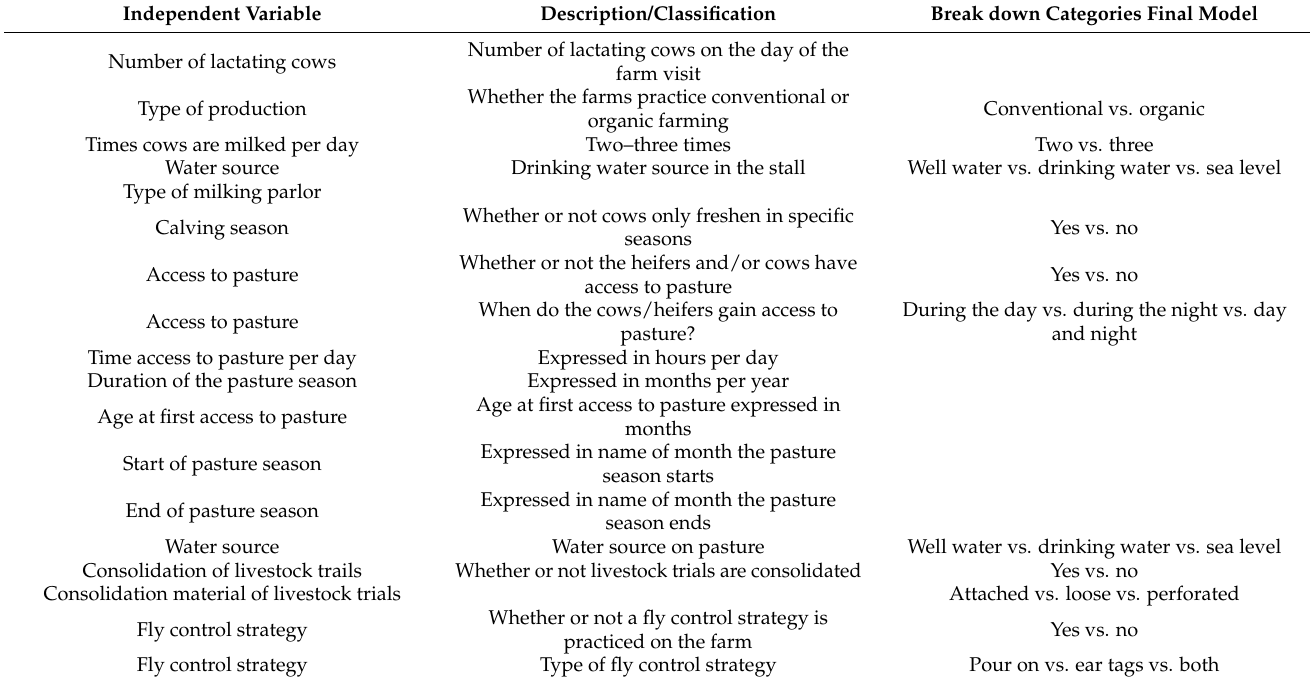
Table A1. General questions raised in the interview concerning farm management, housing, and access to pasture.